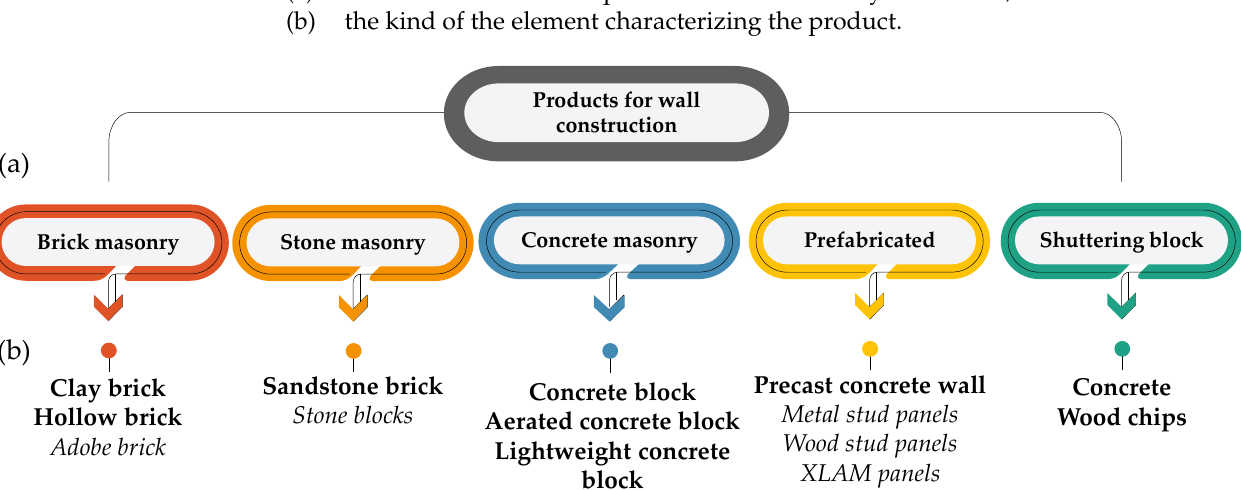
Products for wall